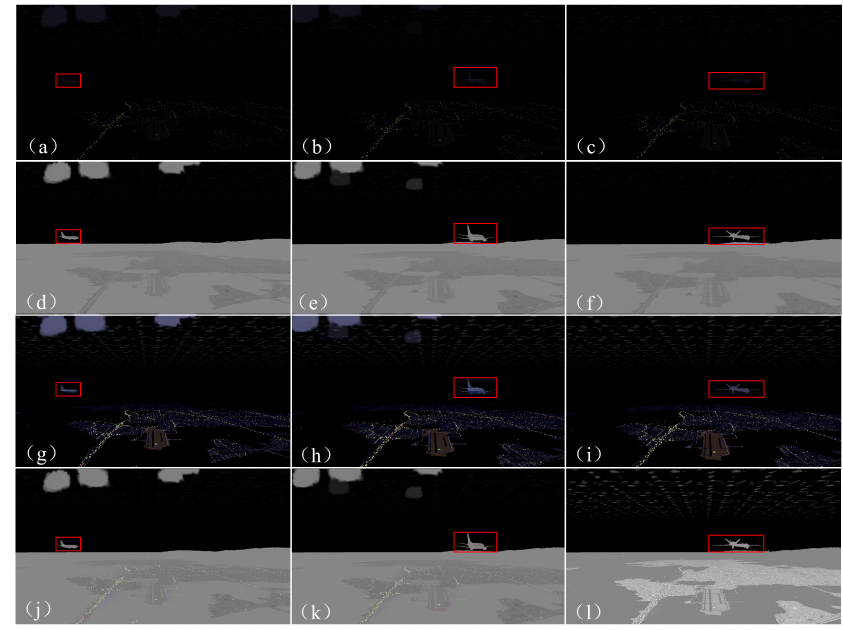
Figure 16. Comparison with the CSR